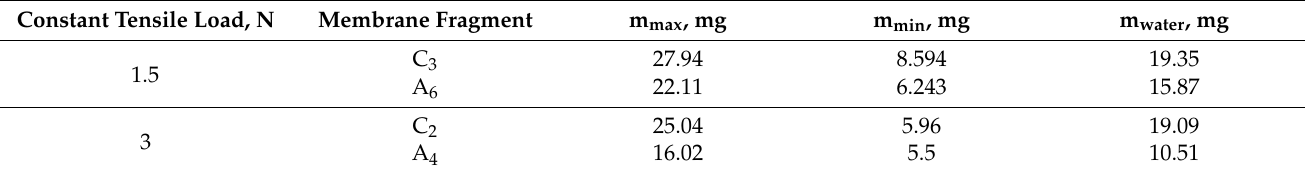
Table 1. The moisture content of membrane fragments.